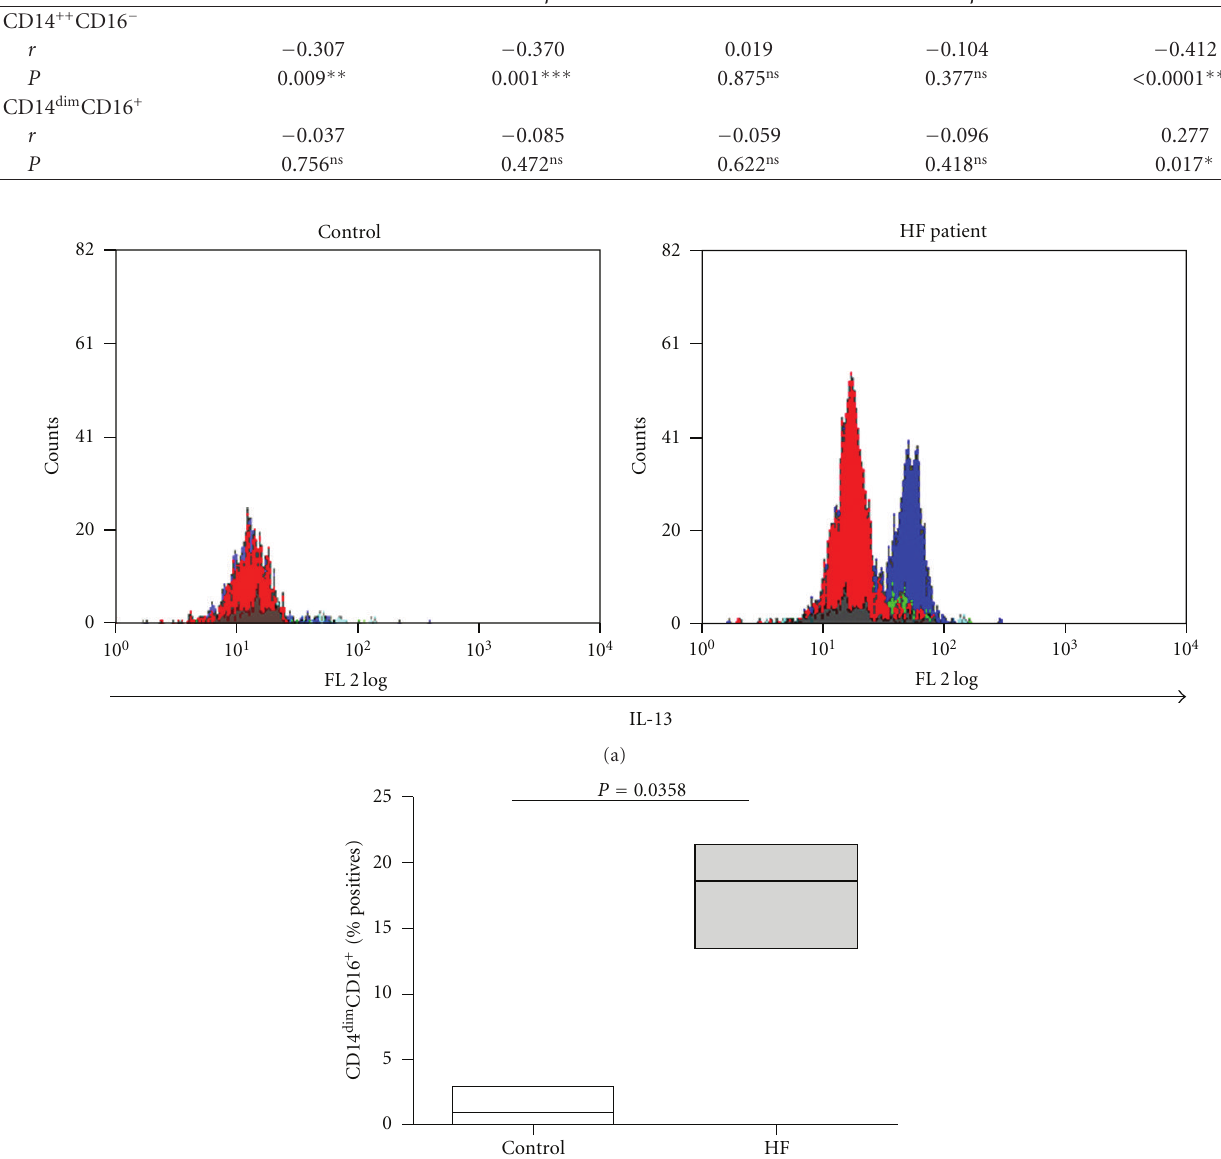
only of symptomatic, systolic HF patients defined as